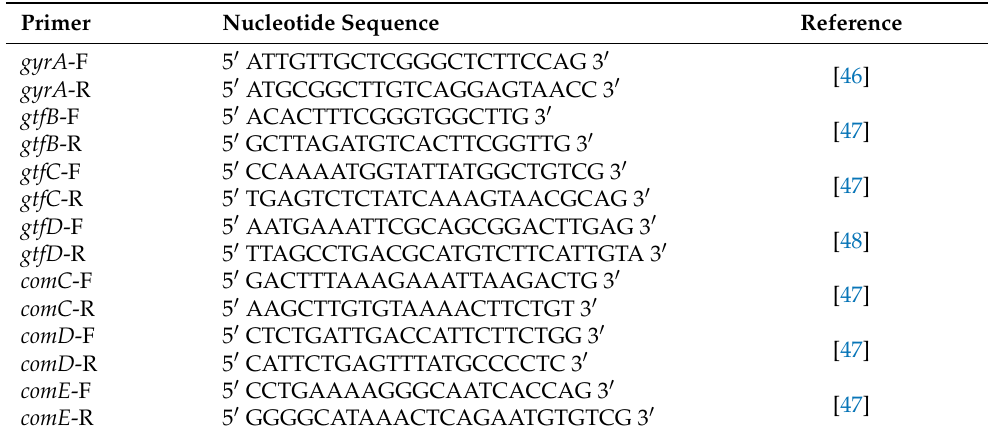
Table 1. Primers and probes used in